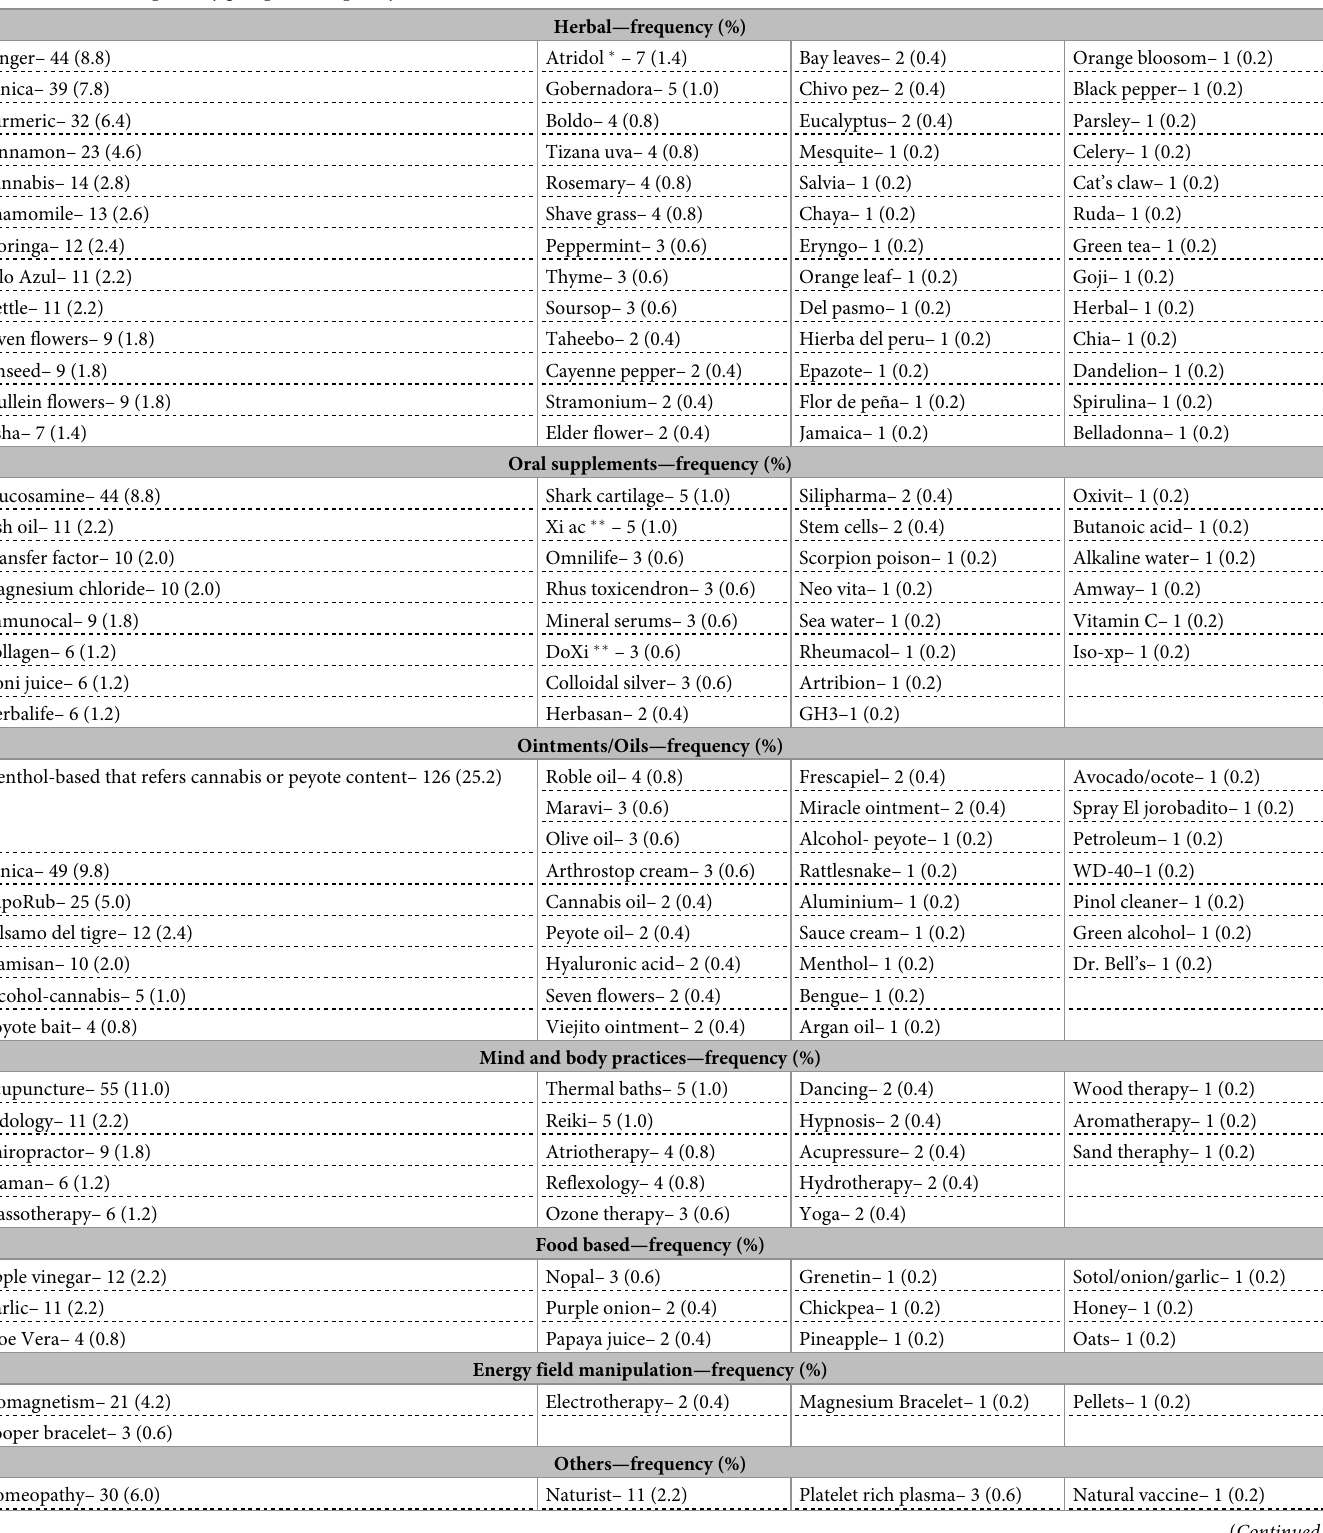
Table 2. CAM description by group and frequency of